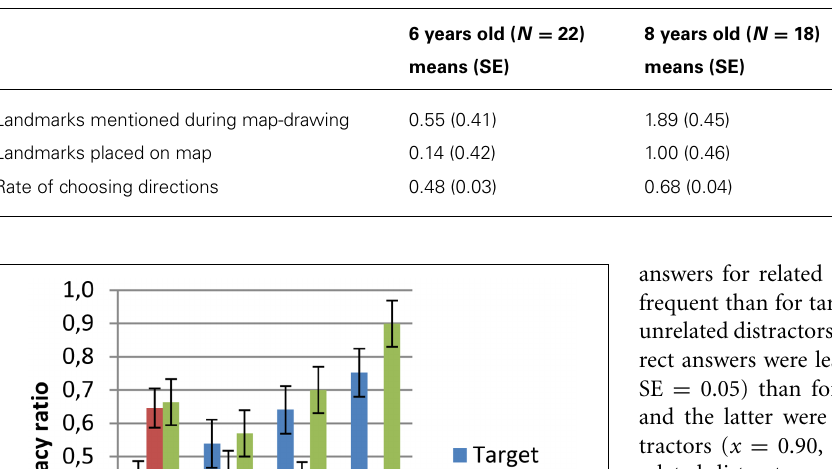
Table 1 | Mentions and placements of landmarks during the map-drawing task, and performance in the direction-choosing task.